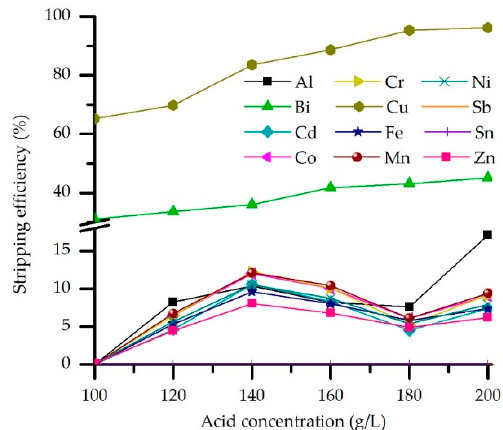
Figure 7. Effect of the H 2 SO 4 concentration on the stripping efficiency (M5640 20 vol.% in loaded OP, O/A = 2, temperature 20 °C, and contact time 5 min).